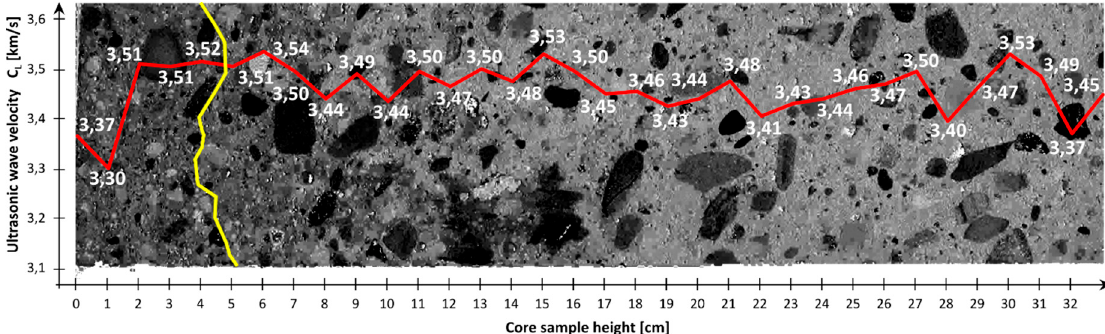
Figure 6. The structure of concrete of the sample taken parallel with the top surface of the slab (slab top surface on left). The image also shows distribution of the mean velocity C L of longitudinal ultrasonic wave (red line) and zone of disturbance at the lateral surface of the slab (yellow